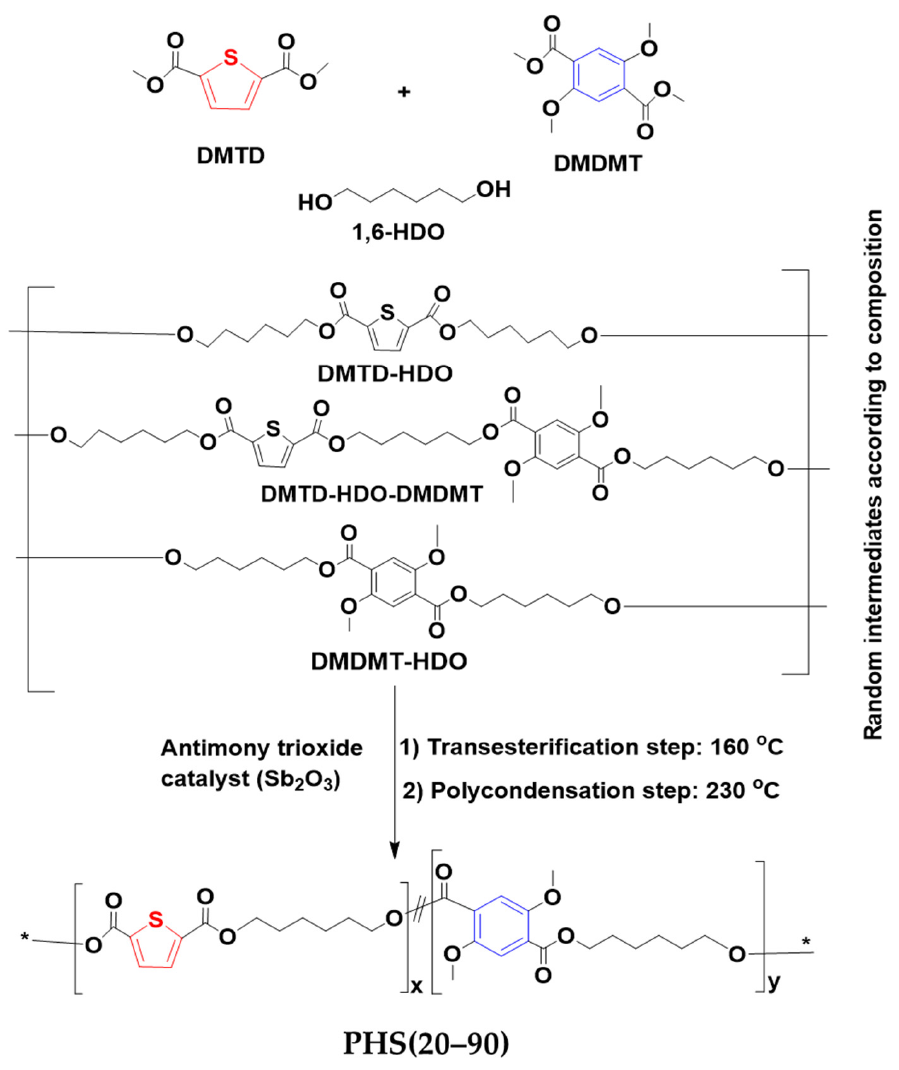
Figure 1. Synthesis of PHS(20–90) copolyesters.